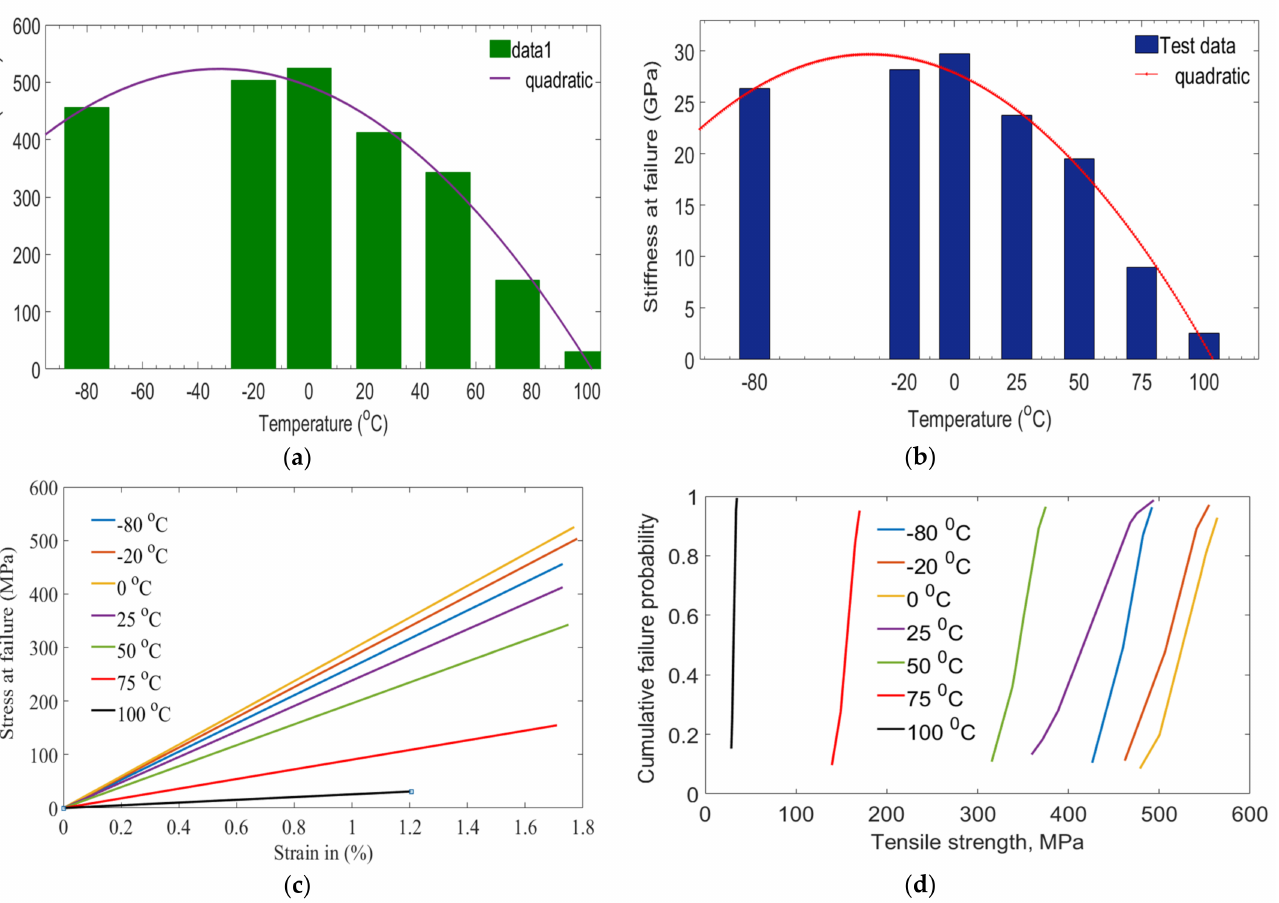
Figure 3. Laminates under different temperatures ( a ) tensile stress, ( b ) stiffness ( c ) stress–strain curves ( d ) cumulative failure